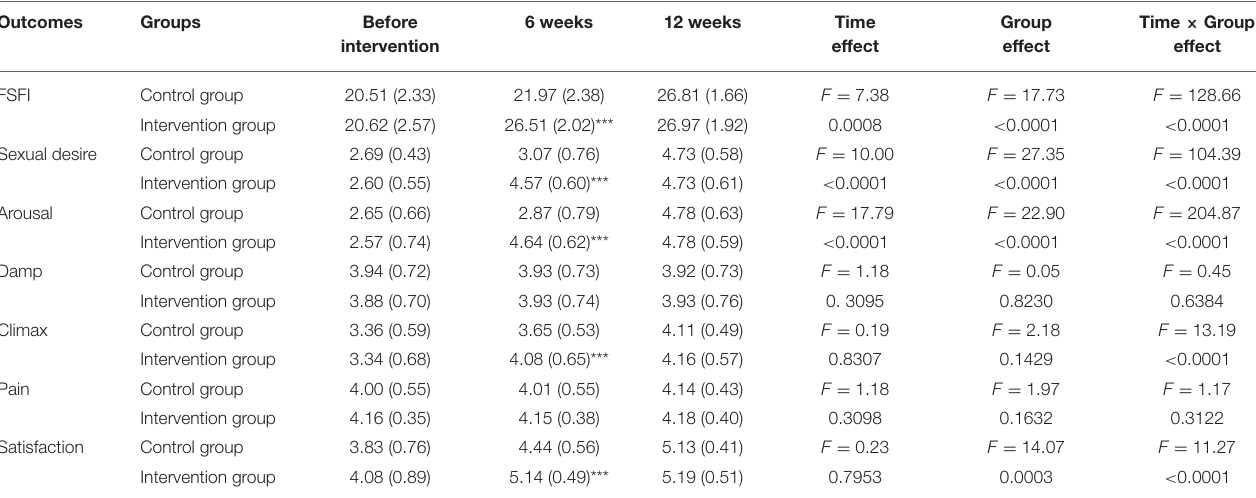
TABLE 4 | Outcomes associated with sexual